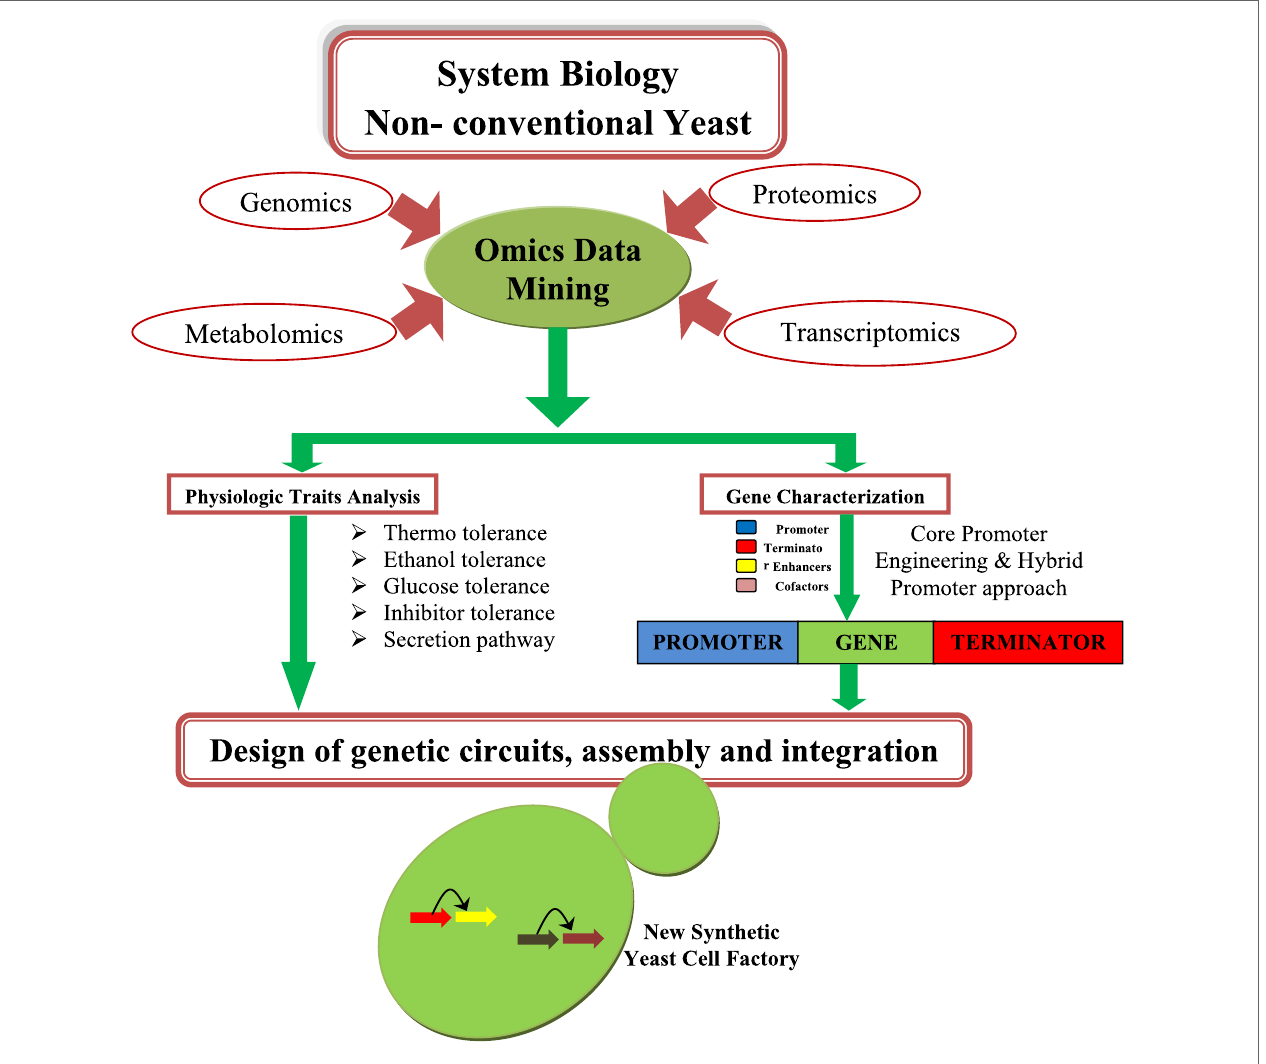
FiGURe 1 | Synthetic biology approaches in non-conventional yeast for biofuel production